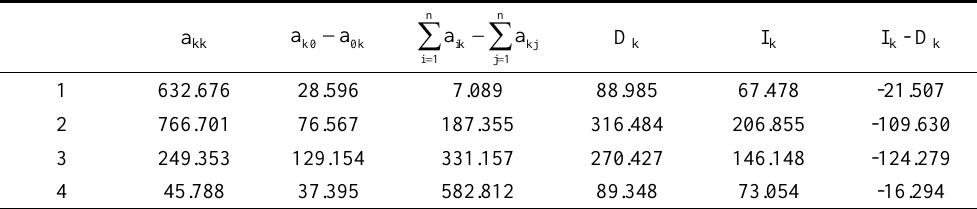
Table 3 Information of lake dynamic evolution from 1984 to 2000 (Unit: km 2